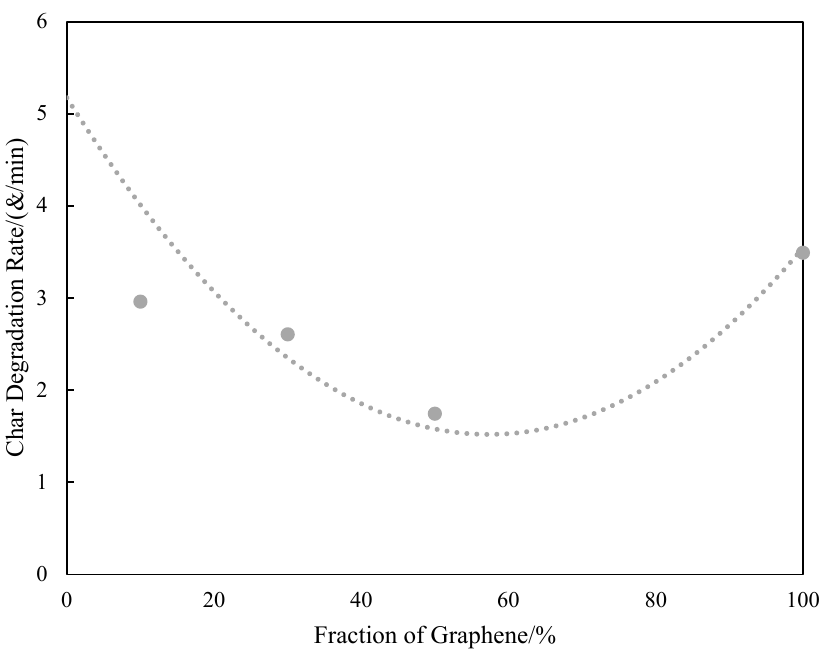
Figure 8. Dependence of the char degradation rate for PI/graphene nanocomposites on wt.% graphene [101].